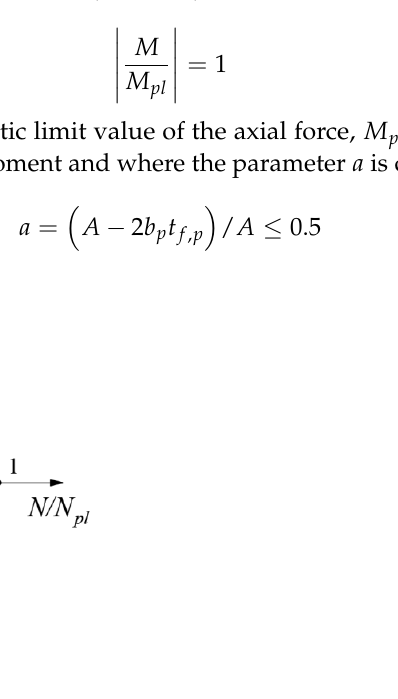
Figure 6. Dimensionless yield domain: the value of 𝑛 depends on the cross-section profile ( 𝑛 = 0.5𝑎 ).